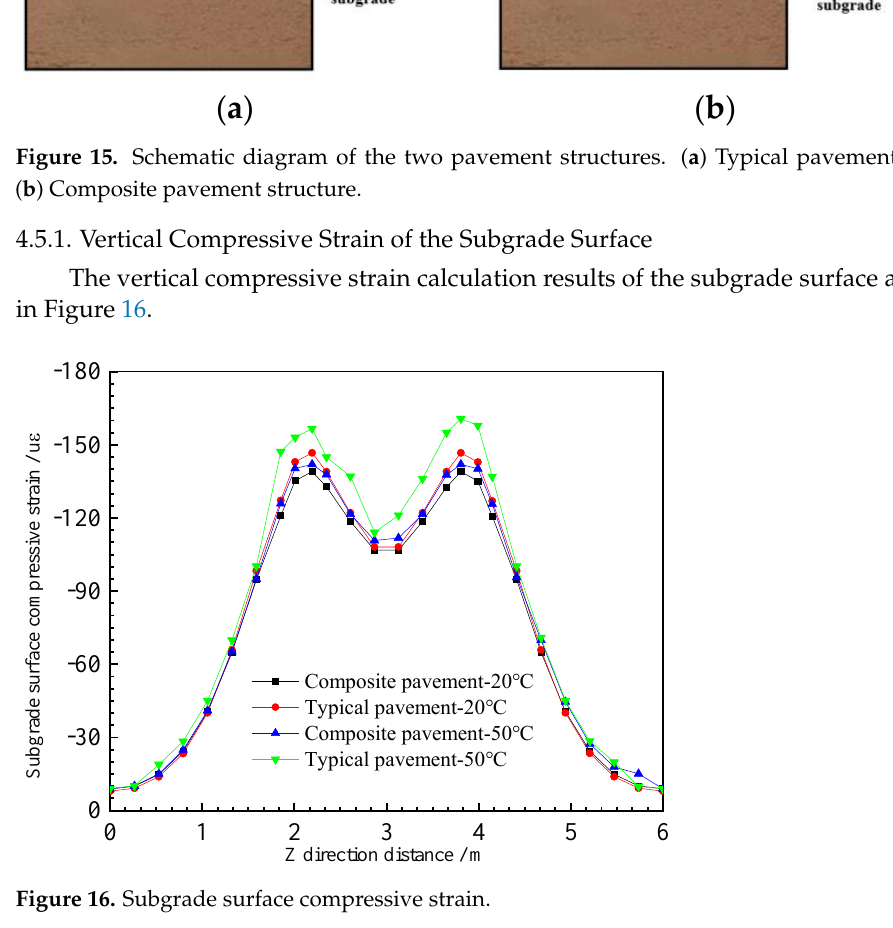
Figure 16. Subgrade surface compressive strain.